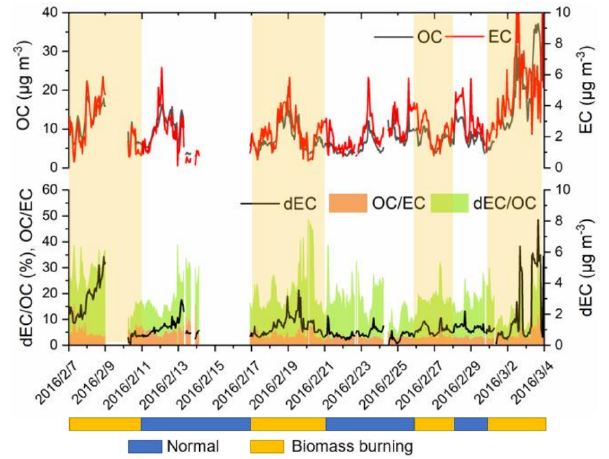
Figure 11. Time series of OC, EC, dEC / OC, dEC and OC / EC from 7 February to 3 March 2016. The period was divided into normal days (blue bars) and biomass burning days (yellow bars). The yel- low shading represents the biomass burning